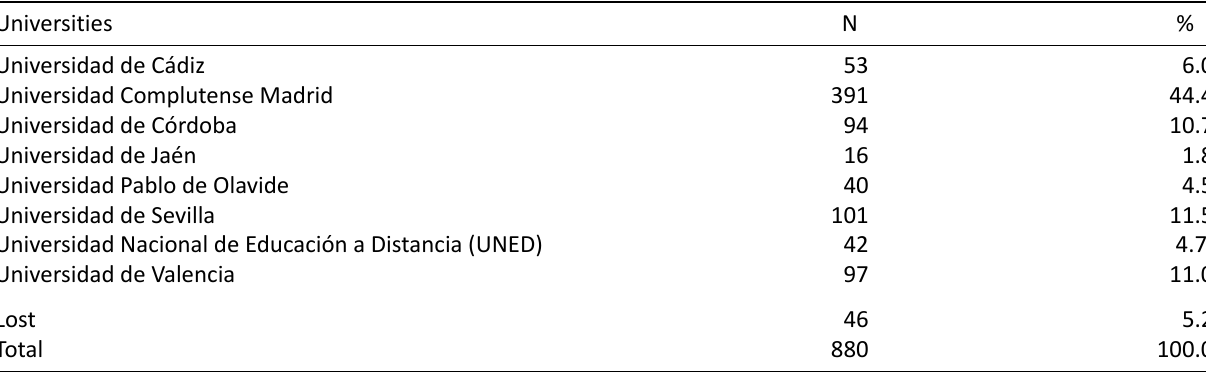
Table 1. Participating